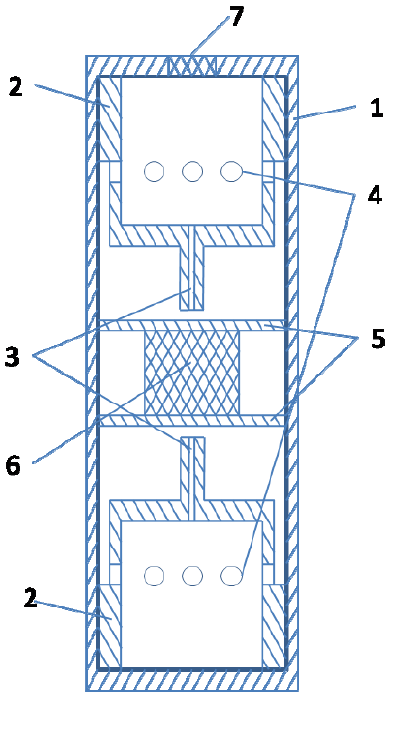
Figure 1. Schematic presentation of the newly developed cell seeding